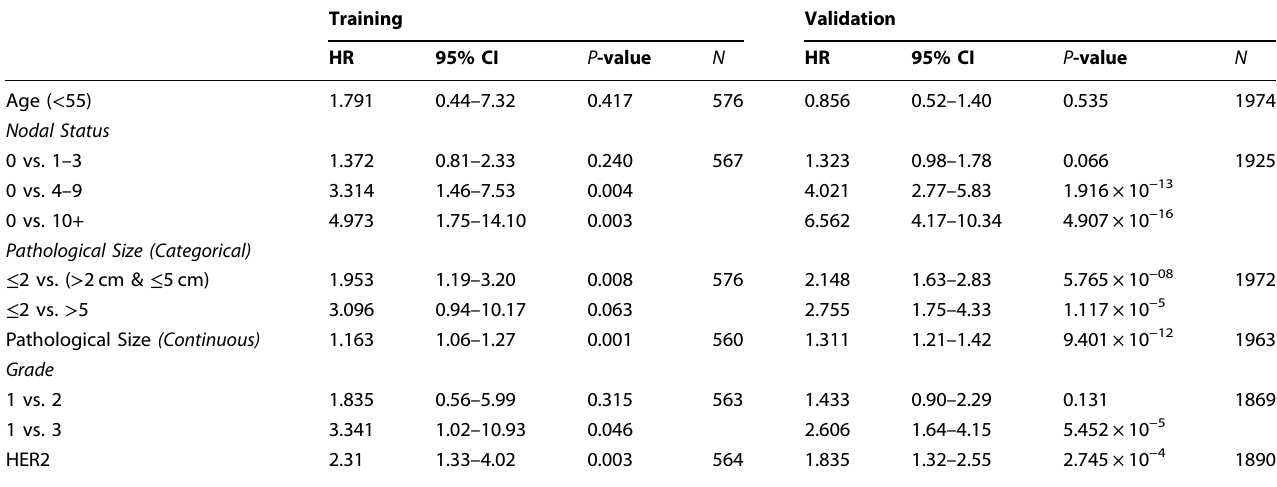
Table 1 Clinical characteristics of the endocrine-treated